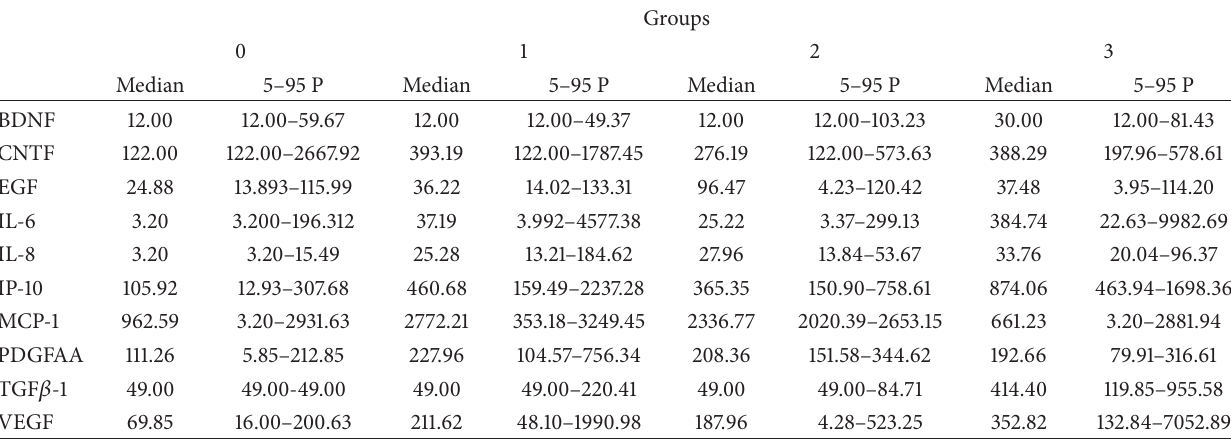
Table 1: Descriptive statistics. Median values and 5th and 95th percentile values in pg/mL for all markers and groups are shown. Proliferative diabetic retinopathy (PDR) patients were divided into groups. Group 1: PDR patients with no need for repeated surgical intervention; group 2: PDR patients with repeated vitreous bleeding, which is a less serious complication of PDR; group 3: PDR patients with refractory neovascular glaucoma, which is a serious complication of PDR; group 0: control group.